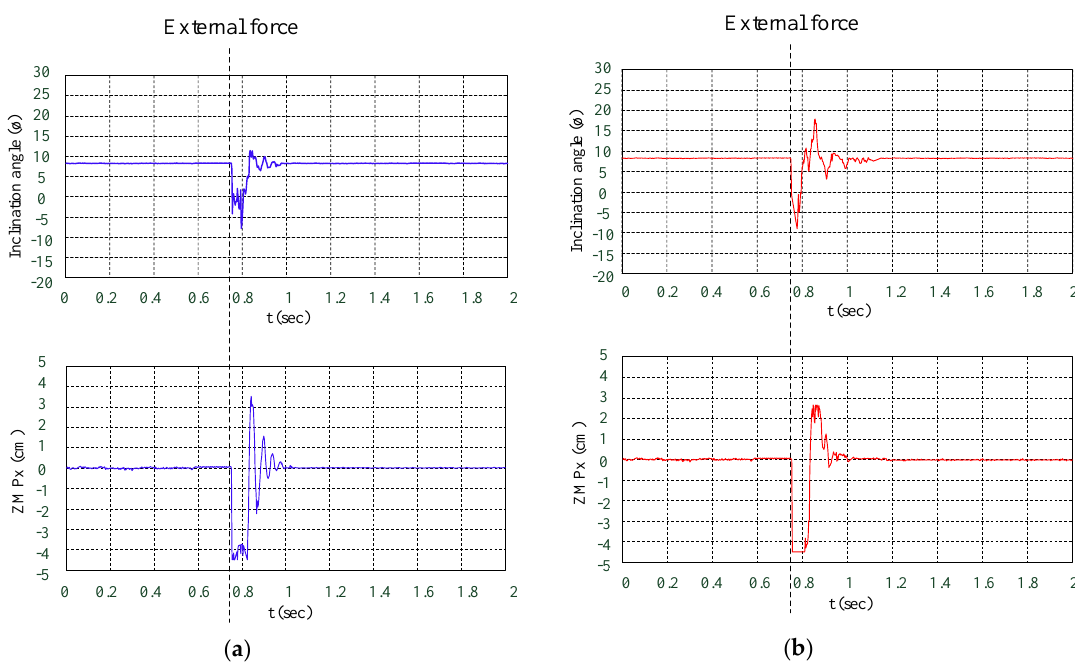
Figure 15. Experimental results of the TKU-X robot hit from the front by a baseball or a volleyball at 0.75 s when the balance control method is disabled. ( a ) Baseball. ( b ) Volleyball.